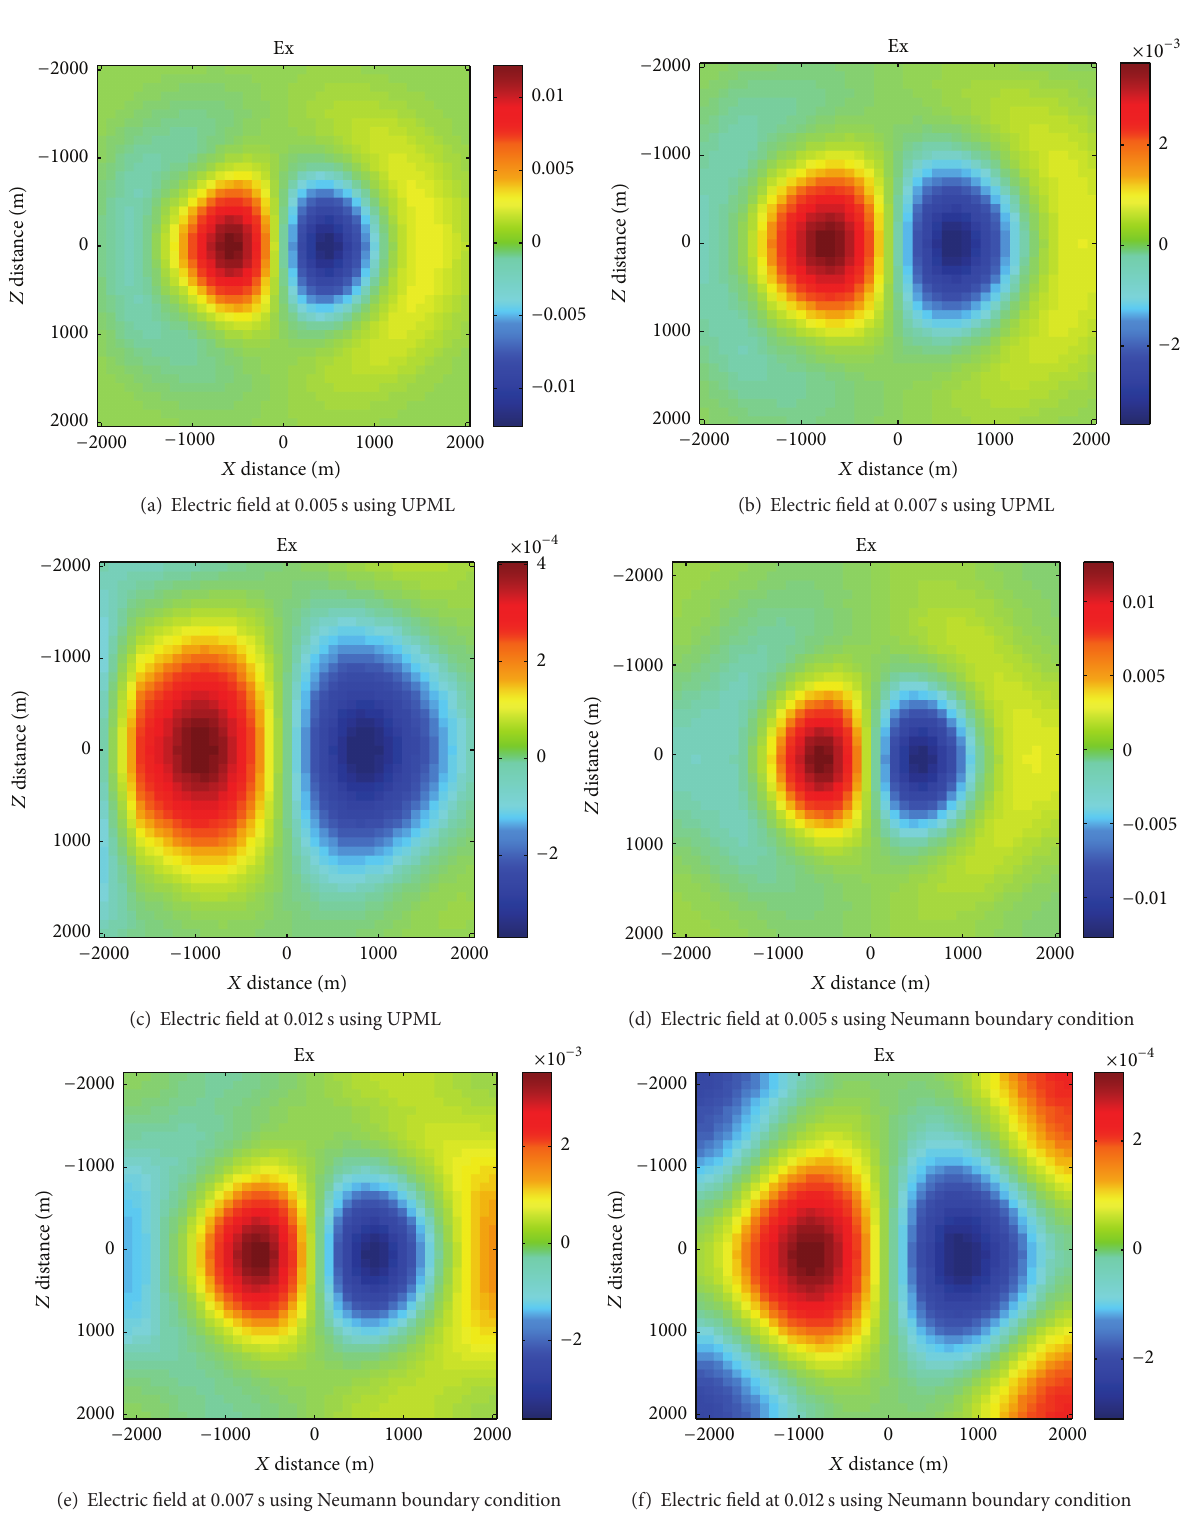
Figure 3: 2D model of a resistive medium using UPML and Neumann boundary